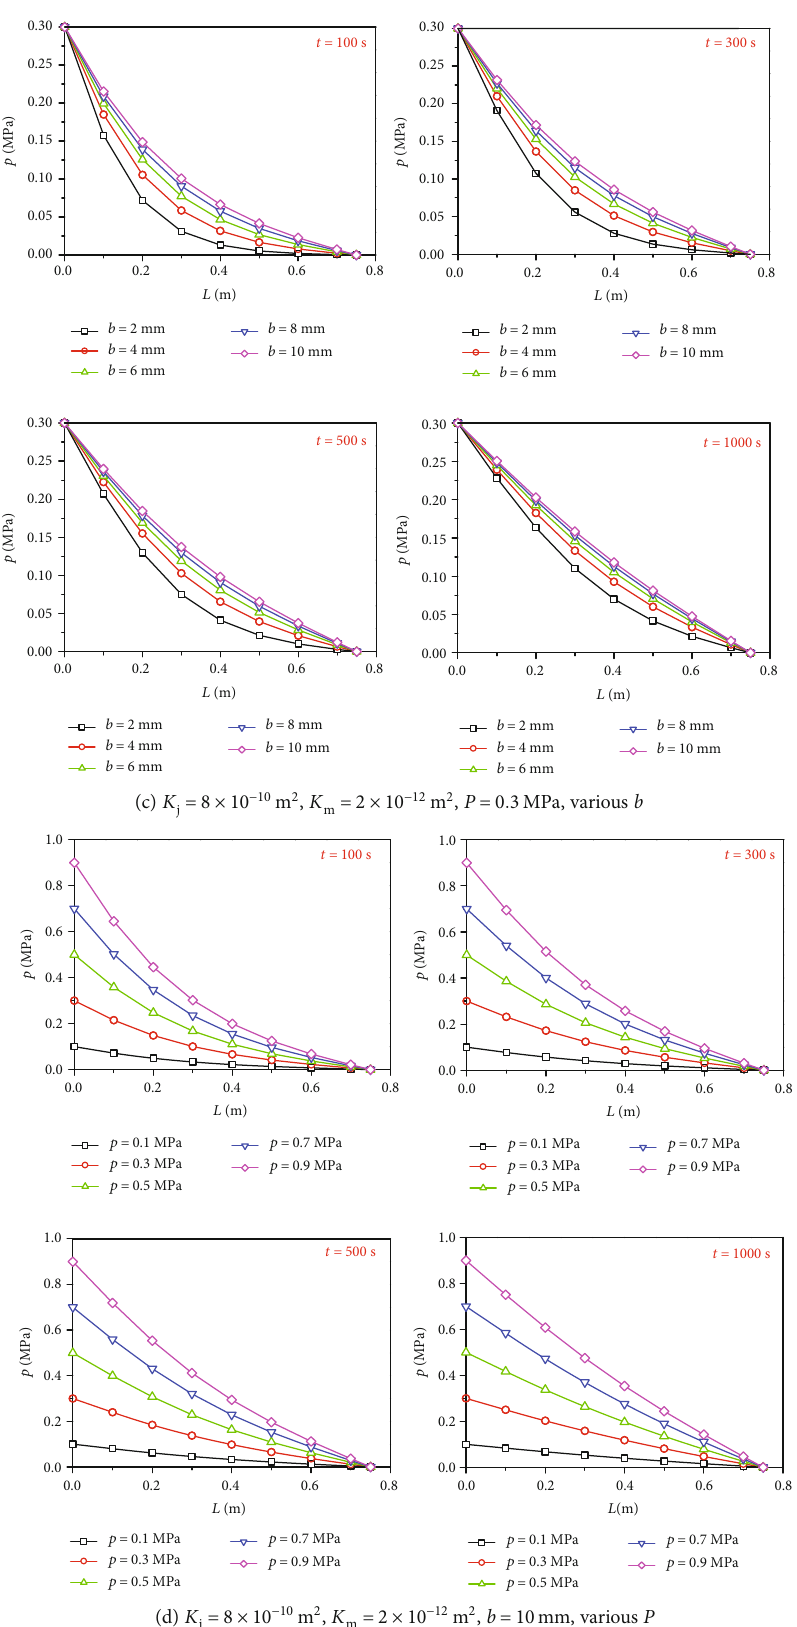
Figure 11: Numerical results and corresponding fi tting curves of p versus L under di ff erent